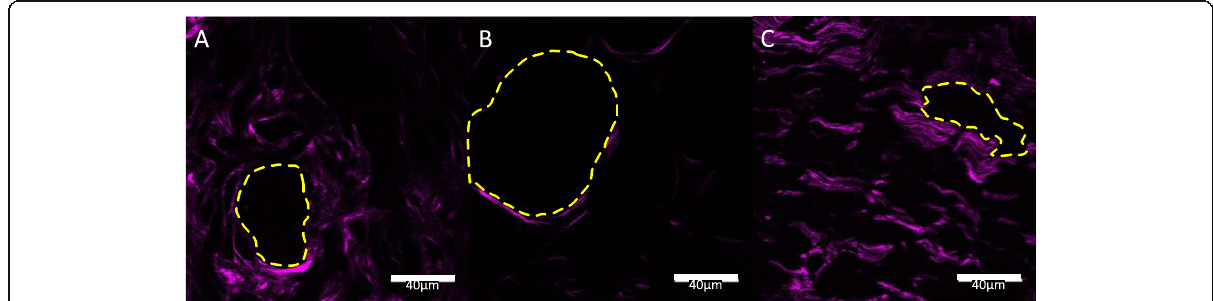
Fig. 3 Second-harmonic generation images of breast cancer. Representation of tumor associated collagen signatures (TACS, see text): a TACS-1; b TACS-2; and c